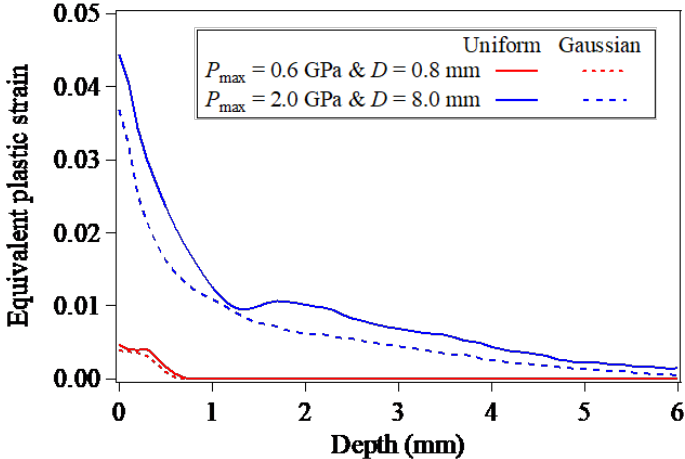
Figure 4. In − depth equivalent plastic strains induced by LSP. Figure 4. In-depth equivalent plastic strains induced by